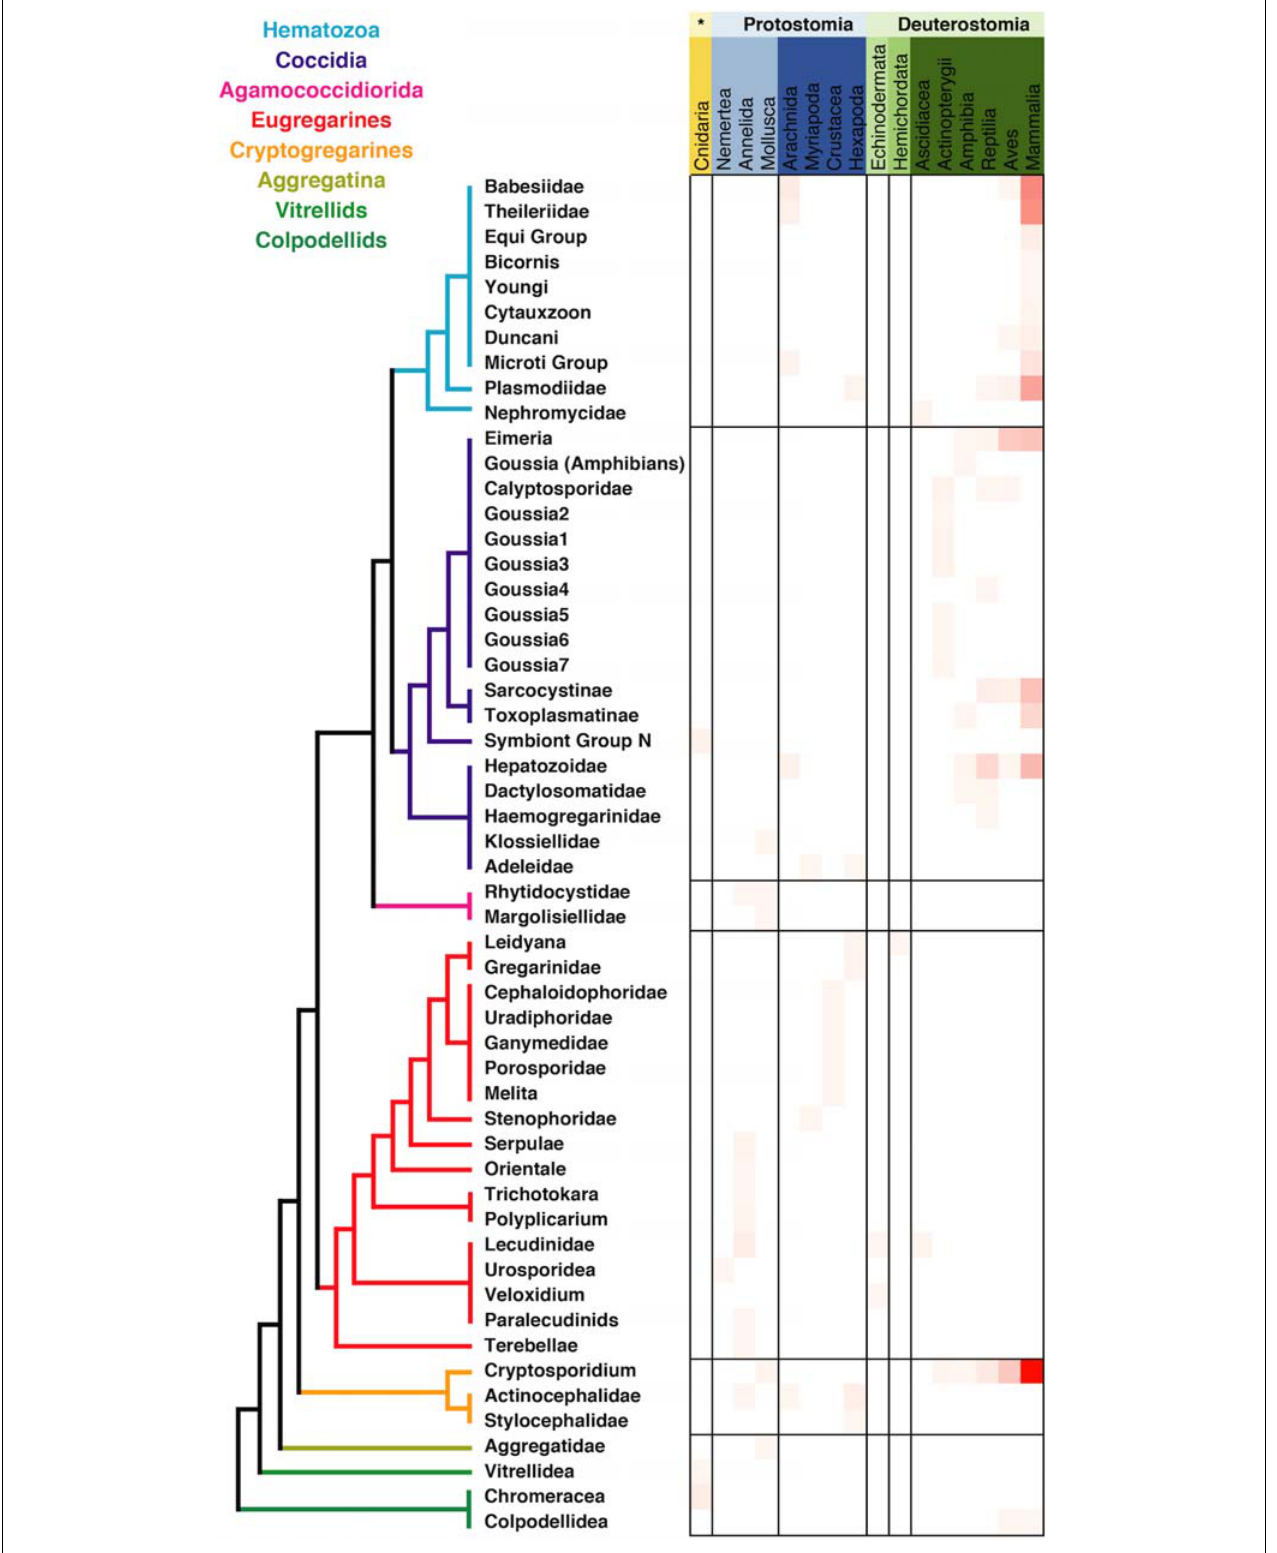
FIGURE 2 | Apicomplexan host distribution heatmap based on the information associated to sequences available in GenBank. Detailed information on the taxonomic annotation of the apicomplexan sequences used in this figure is available in Supplementary Table S1 .